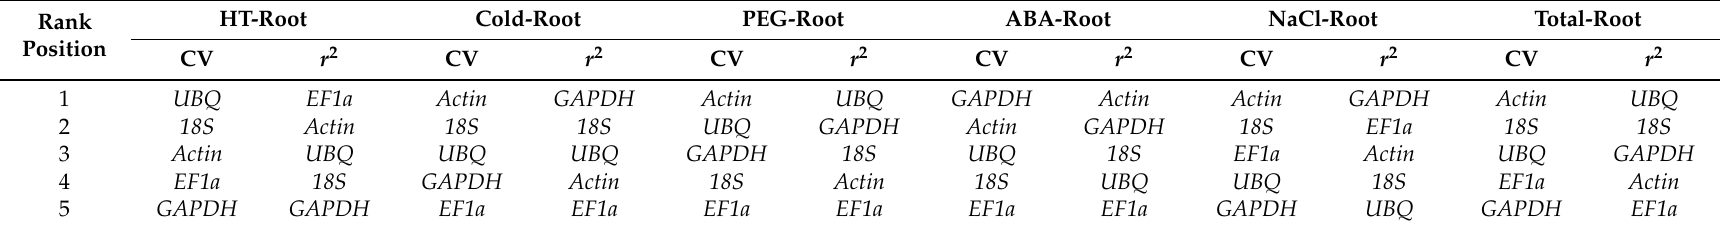
Table 3. Expression stability values and ranking of HKGs in Chinese fir root as calculated by BestKeeper.